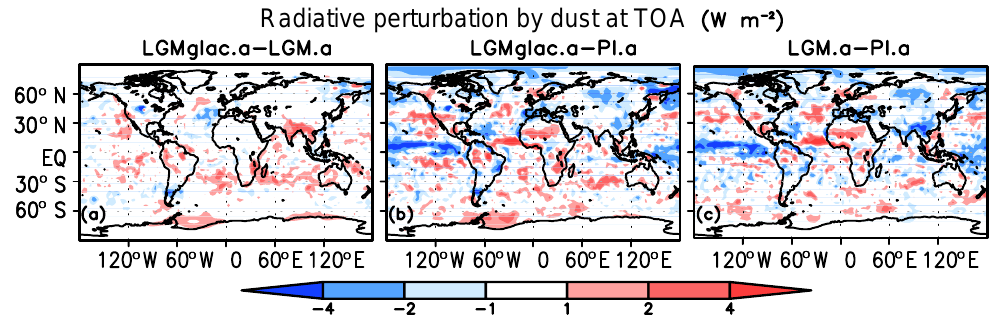
Figure 9. Change in net radiative perturbation by dust at the top of the atmosphere (TOA): (a) LGMglac.a–LGM.a, (b) LGMglac.a–PI.a, and (c) LGM.a–PI.a.